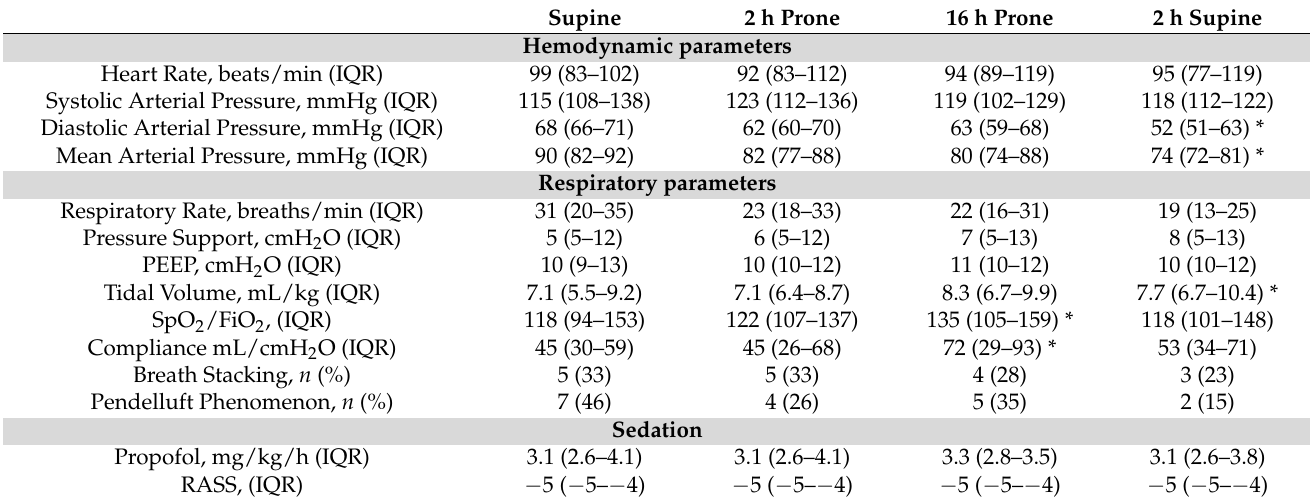
Table 2. Hemodynamic and respiratory parameters during the different phases of the study.